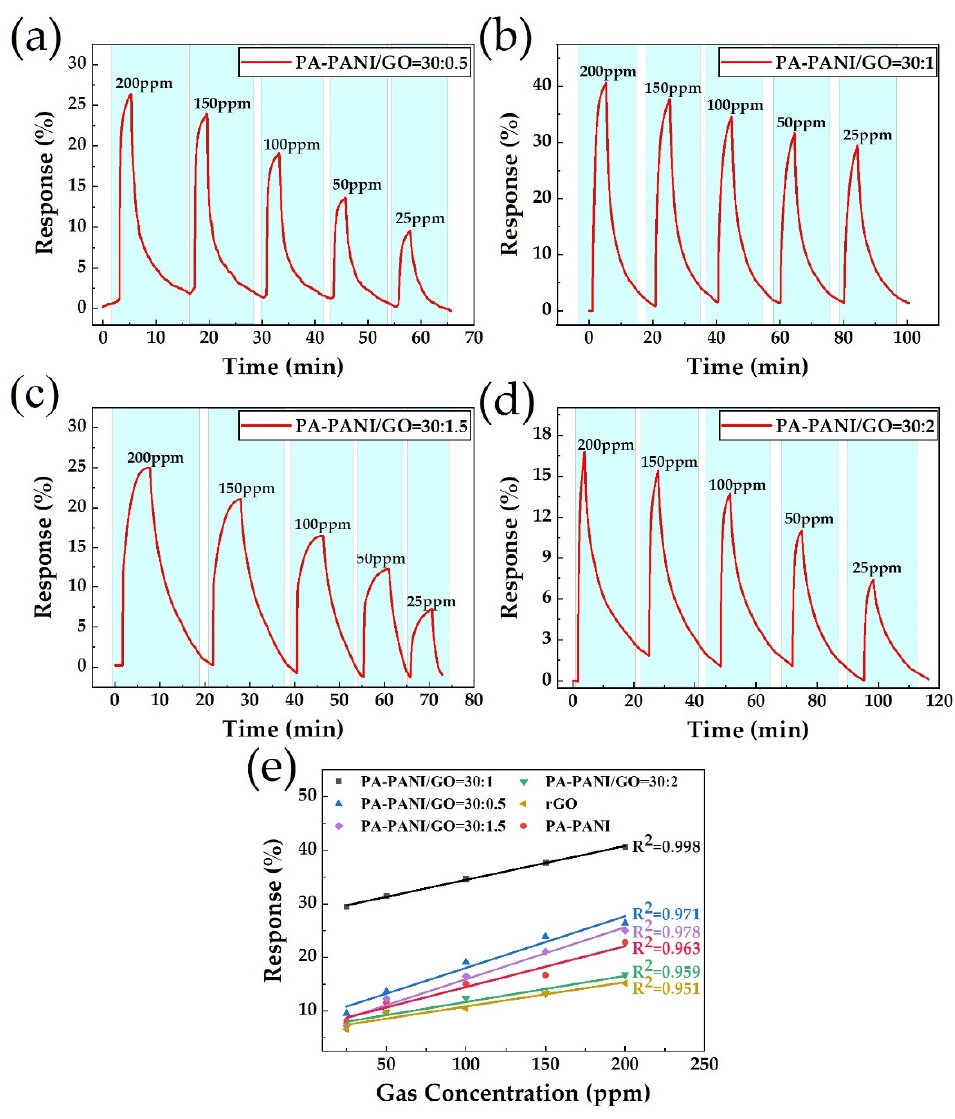
Figure 6. Gas-sensing response based on mixing ratio of ( a ) 30:1 PA-PANI and GO; ( b ) 30:1.5 PA-PANI and GO; ( c ) 30:0.5 PA-PANI and GO; ( d ) 30:2 PA-PANI and GO; ( e ) Linear regression of response for different mix proportions of every group.